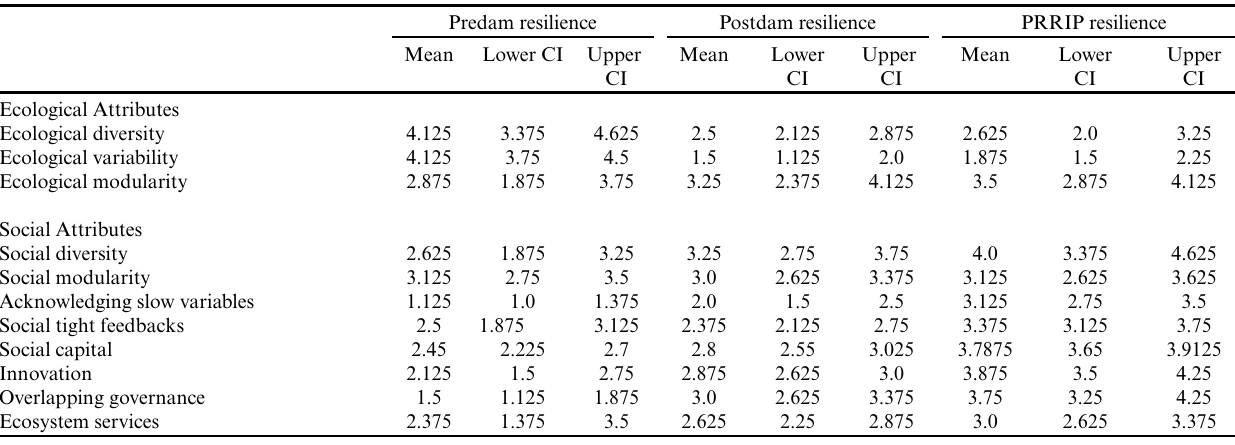
Table 2 . Mean (n = 8) scores for resilience and lower and upper confidence intervals for each of Walker and Salt’s (2006) resilience properties as applied to the central Platte River social-ecological system. The confidence intervals were obtained using the equal-tail percentiles from the nonparametic bootstrap sample of the mean using 100,000 bootstrap iterations (Efron and Tibshirani 1993). Two means are significantly different if their confidence intervals do not overlap. PRRIP = Platte River Recovery Implementation Program.